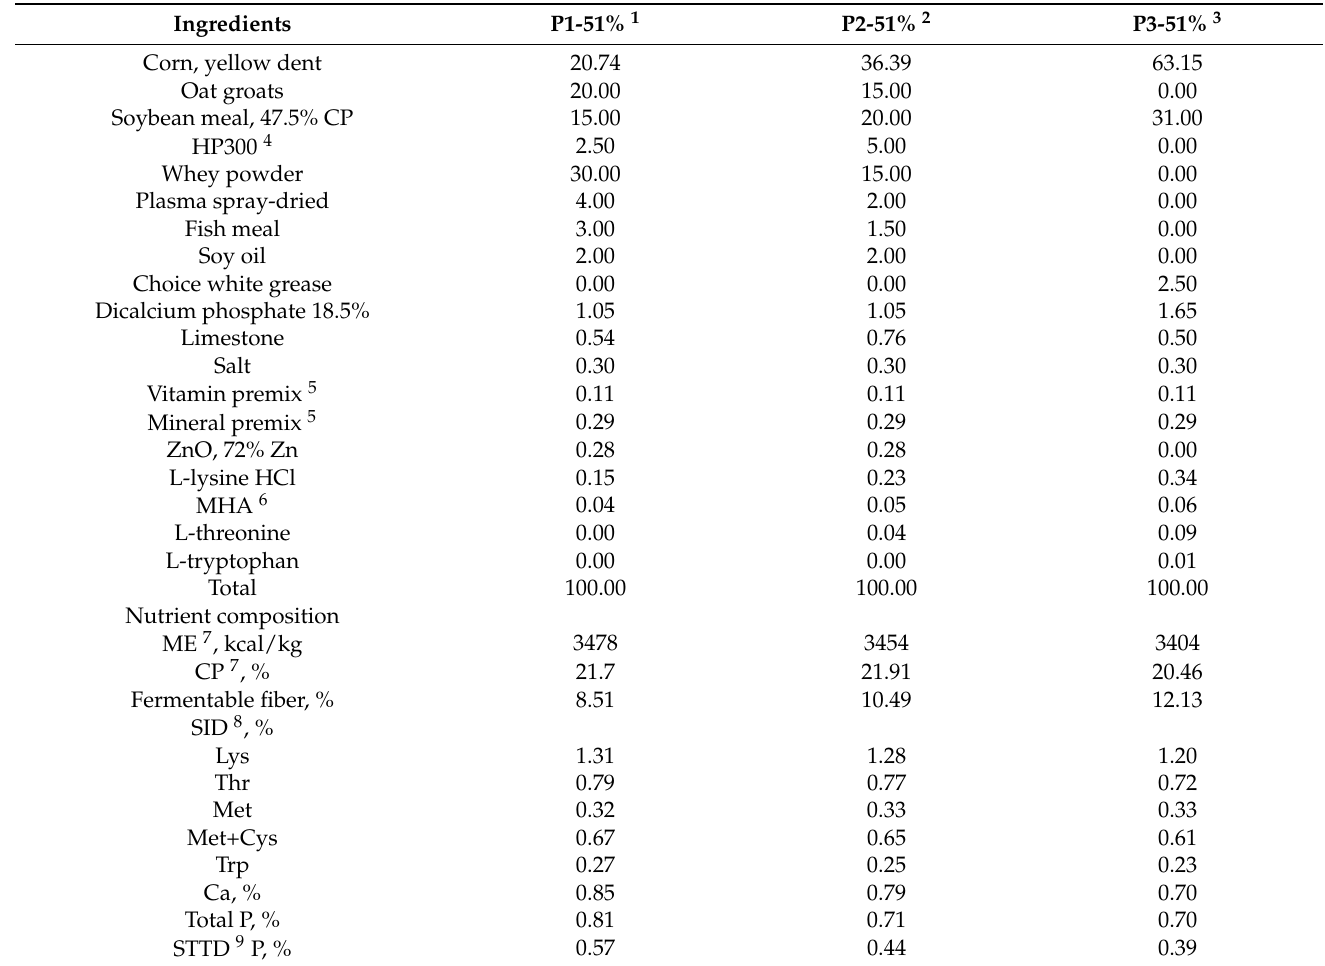
Table 2. Ingredient and nutrient composition of phase 1 (d 0–7), phase 2 (d 7–21), and phase 3 (d 21–42) basal diets with